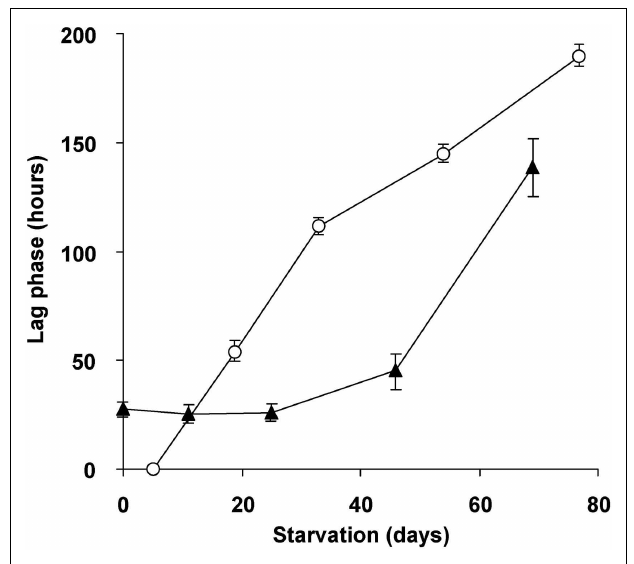
FIGURE 8 |Viability and recovery of glycogen containing “ Ca. M. fumariolicum” SolV cells (closed triangles) and exponentially growing cells (open circles) after methane and ammonium starvation for different periods of time. At time 0, cells were inoculated into optimal medium (4mM ammonium and methane in the headspace) and lag phases were recorded. Error bars represent SEM ( n =